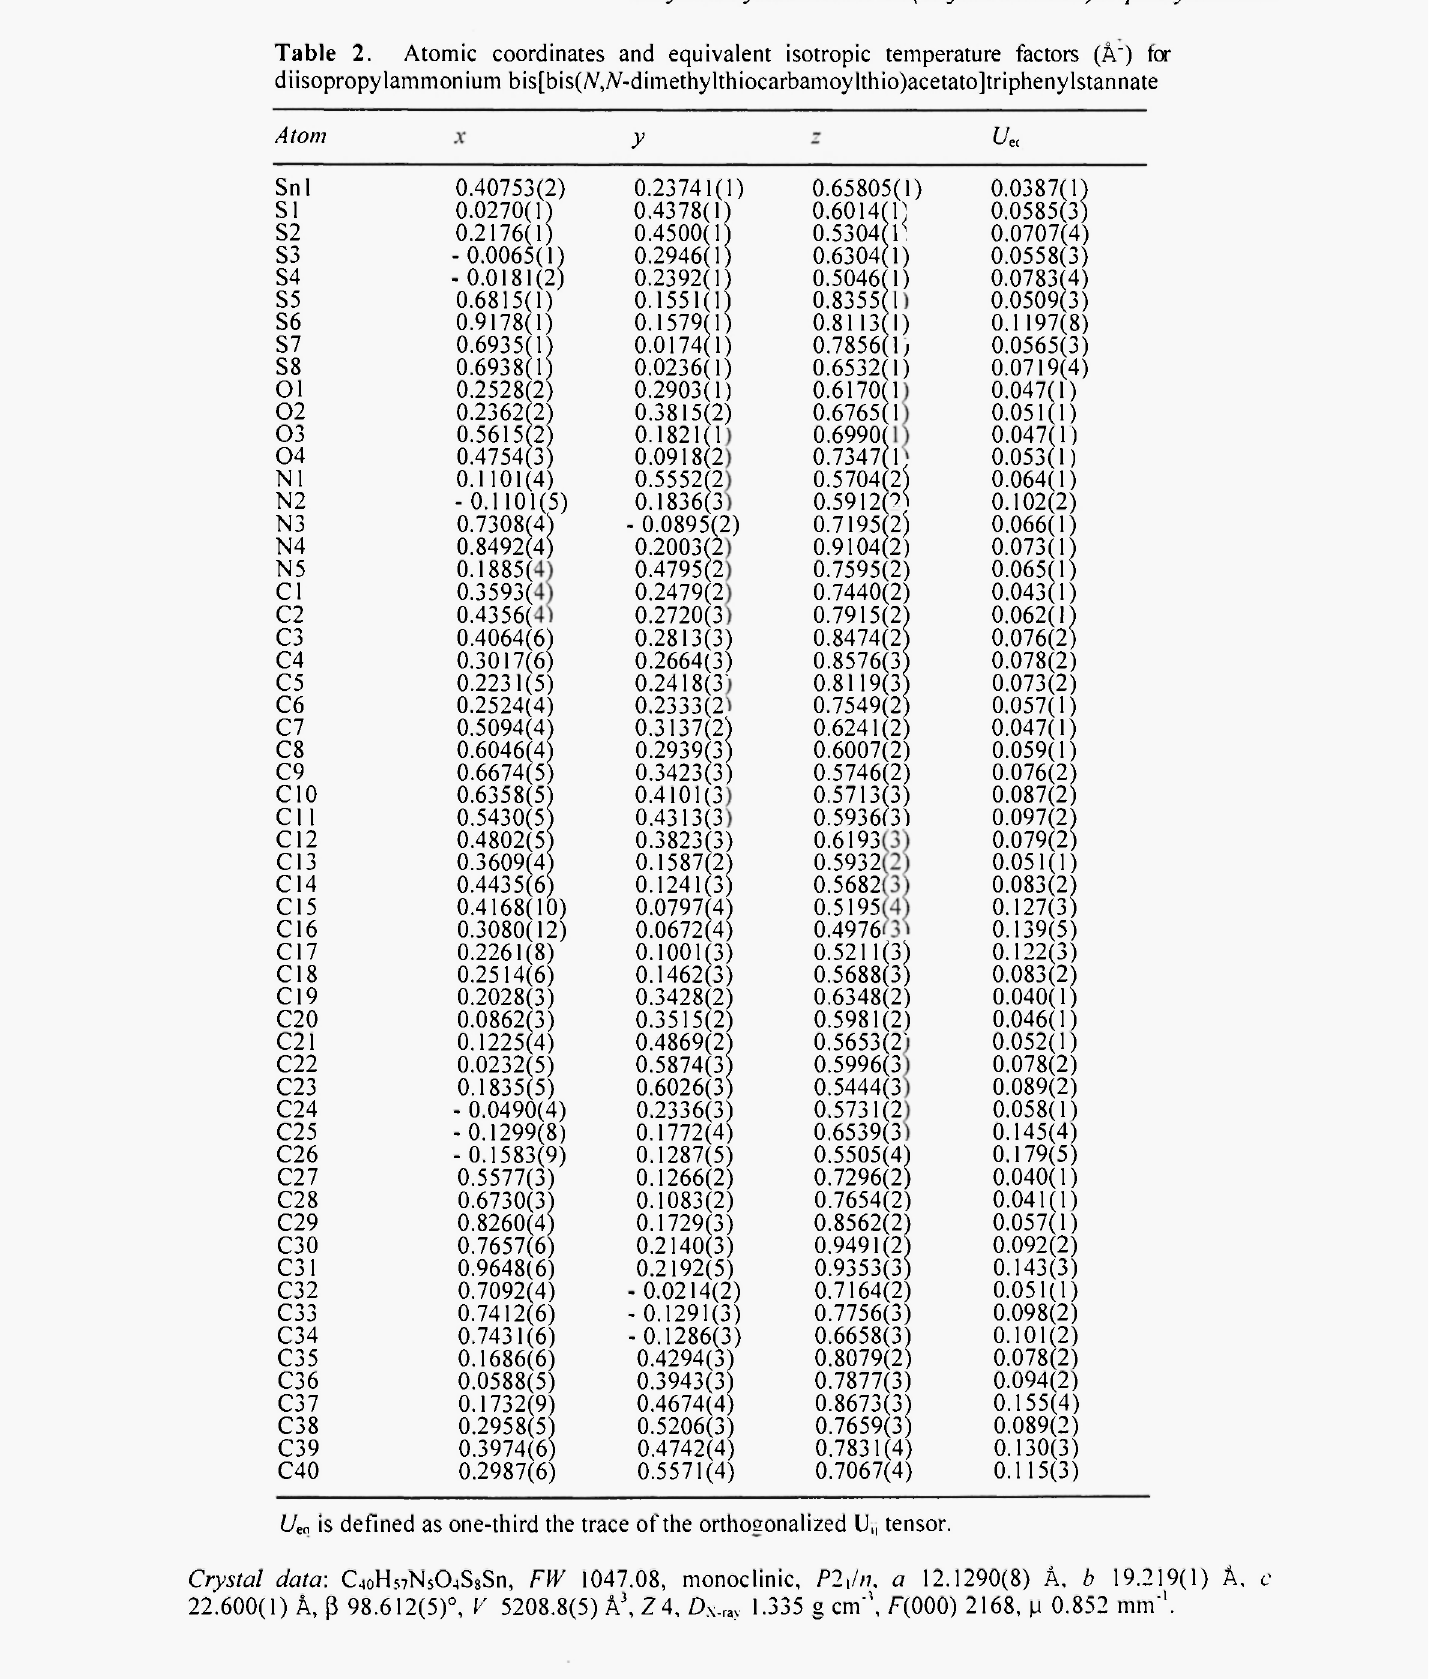
Table 2. Atomic coordinates and equivalent isotropic temperature factors (A") for diisopropylammonium bis[bis(A ,